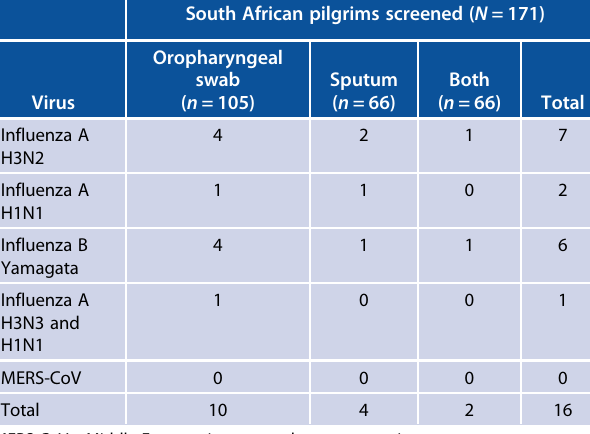
Table 3: Virus identification among a subset of South African pilgrims returning from the 2013 Hajj